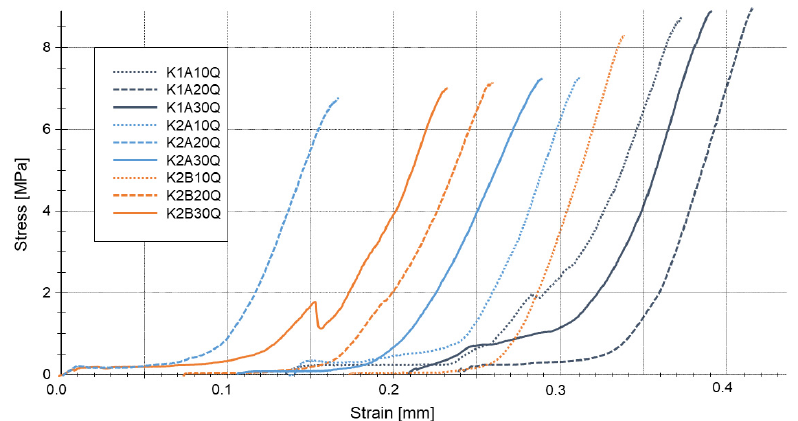
Figure 9. Cold bending strength analysis of potassium water glasses with aluminum metaphosphates Figure 9. cold bending strength analysis of potassium water glasses with aluminum metaphos- (leaned on testing standard DIN EN 853-2-2007). Samples analogous to Table 2 phates (leaned on testing standard DIN EN 853-2-2007). Samples analogous to Table 2 [24].